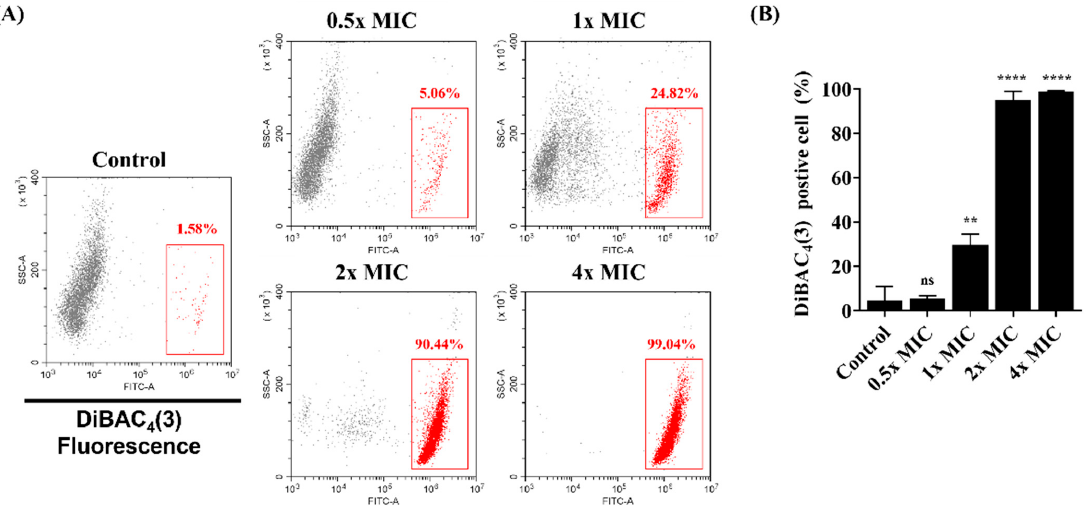
Figure 2. Analysis of Candida albicans membrane depolarization after treatment with Lycosin-II. ( A ) Changes in membrane depolarization in C. albicans after treatment with Lycosin-II with the peptide at 0.5×, 1×, 2×, and 4× MICs were investigated using flow cytometry with DiBAC4(3). ( B ) The statistical analyses are displayed as averages ( n = 3). The graph is expressed as the mean ± standard deviation. Significance: **, p < 0.01; ****, p < 0.0001; ns, not significant compared to the control. Abbreviations: MIC, minimum inhibitory concentration; DiBAC4(3), bis(1,3-dibutylbarbituric acid) trimethine